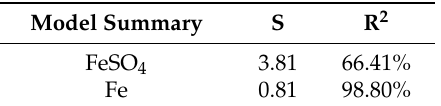
Table 7. ANOVA model summary.